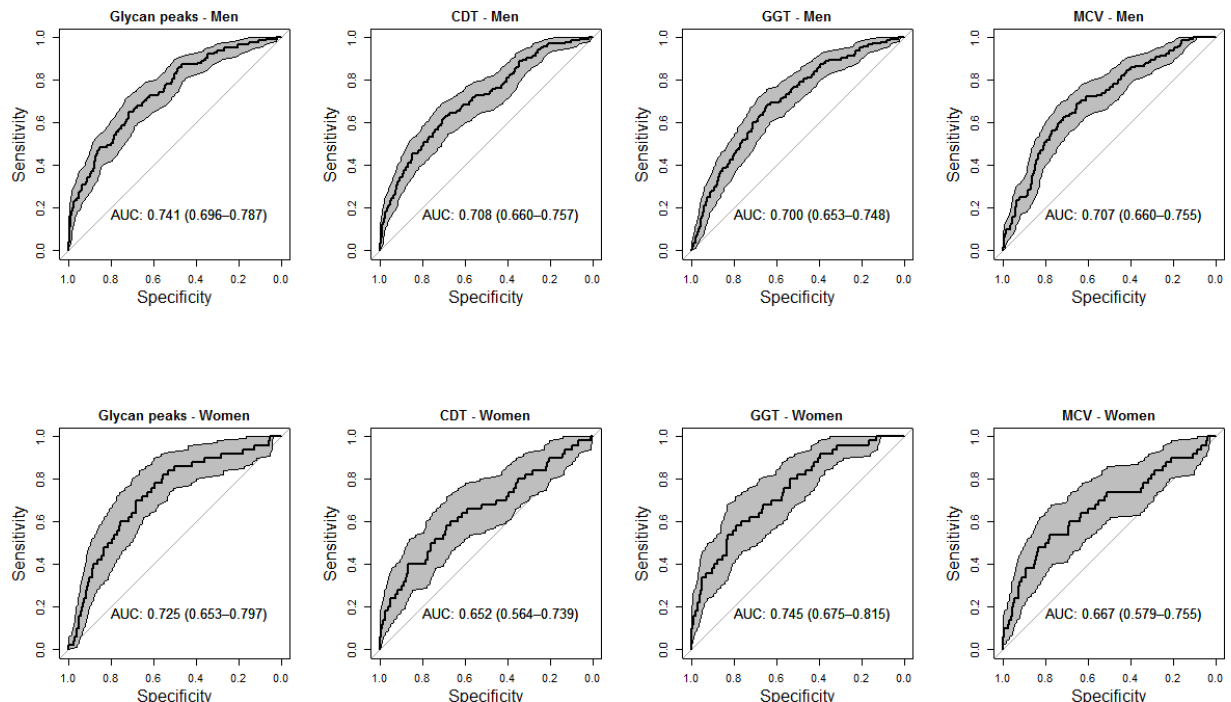
Figure 3. Receiver-operating characteristic (ROC) curves comparing the accuracy of serum N -glycan balance and commercial markers (serum carbohydrate-deficient transferrin [CDT], serum gamma- glutamyltransferase [GGT], and red blood cell mean corpuscular volume [MCV]) for the diagnosis of risk drinking in men (upper panels) and women (lower panels). All analyses were adjusted for age and smoking. Shadowed areas represent the 95% confidence interval of the ROC curve. Numbers in boxes represent the area under the curve with 95% confidence interval (within parentheses).